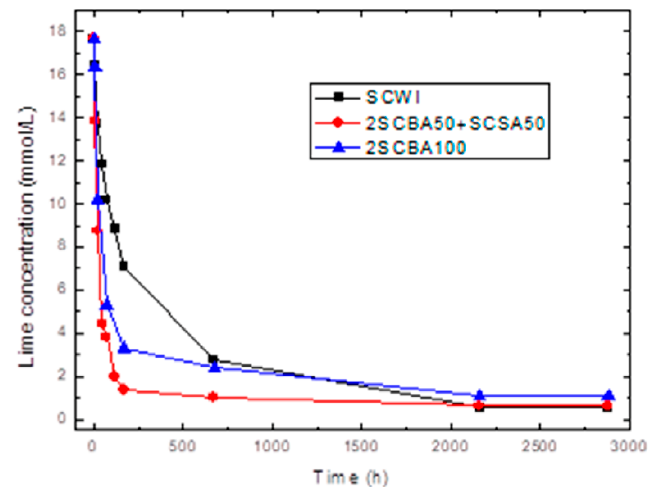
Figure 2. Variation of electrical conductivity with reaction time for the binary system 2SCBA + SCSA.